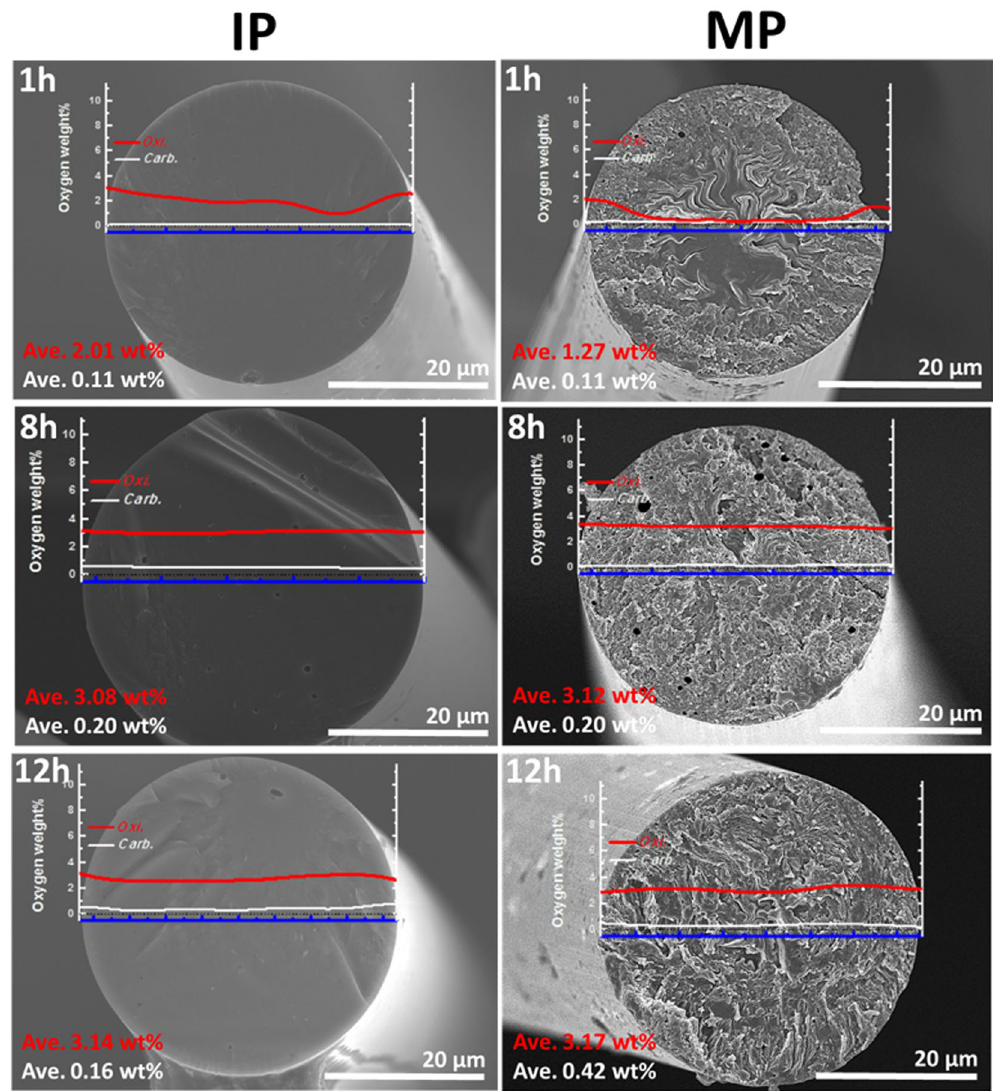
Figure 6. Cross-section SEM images of CFs prepared with different methods and oxidation times. The oxygen distributions across the fiber diameter of each OF and CF are overlapped on the SEM images. The red and white lines indicate the values after oxidation and carbonization,